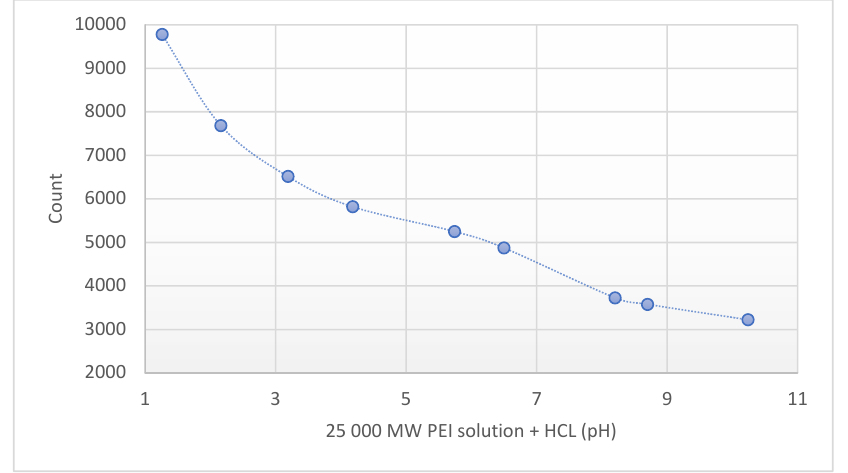
Figure 3. Fluorescence intensity of 25 kPEI solution (10 mg/mL) at different pH. Technical parameters: λ ex = 280 nm; λ em = 290–720 nm; scan speed = 1200 nm/min; PMT voltage = 700 V. Maximal emission: λ em = 560 nm. The standard 3.5 mL quartz cuvette were OD: 12.5 mm × 12.5 mm × 45 mm; wall thickness: 1.25 mm with 10 mm light path and four polished sides. The volume of all the samples was 1 mL.